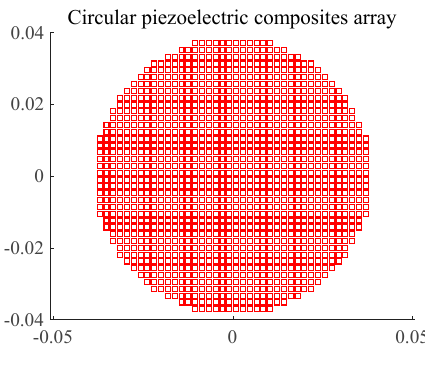
Figure 3. Circular Transmitting Array.